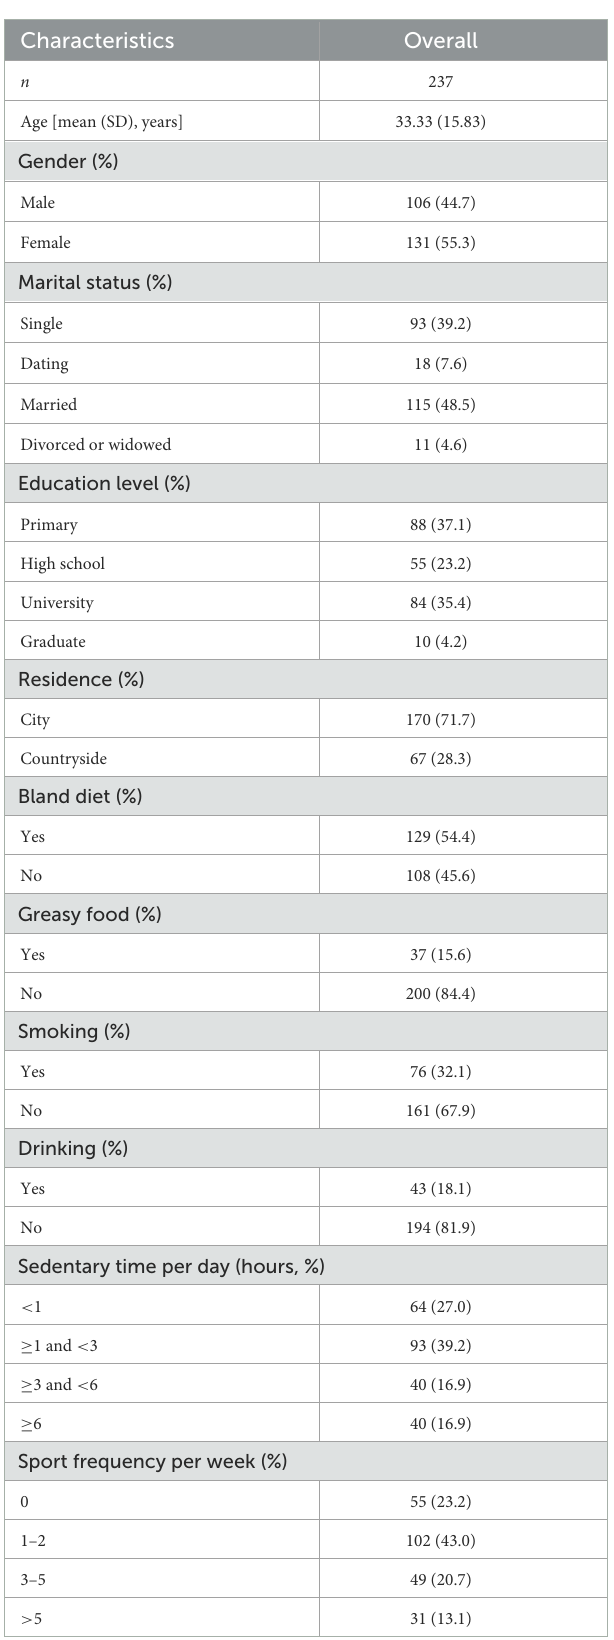
TABLE 1 Patient’s basic characteristics, living habit, and mental health status.